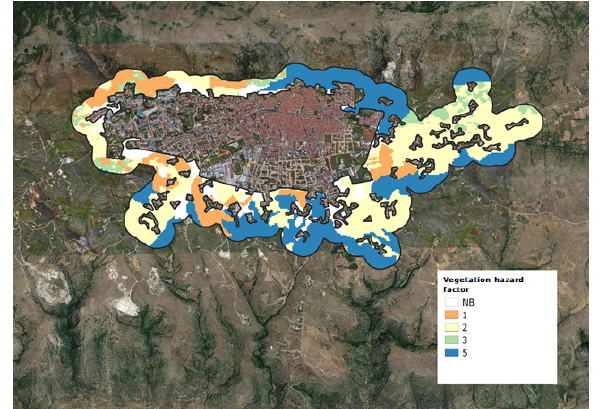
Figure 6 . Vegetational Hazard